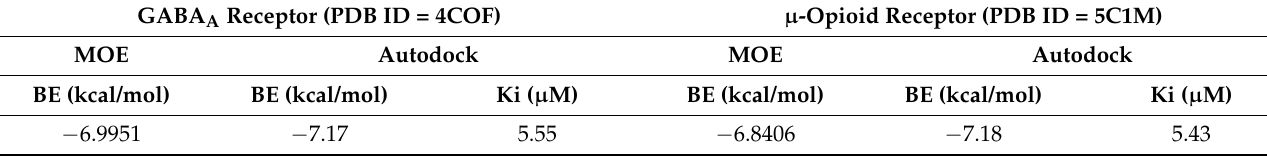
Table 6. Binding energy and inhibition constant of the salicylalazine calculated by Autodock into the binding site of µ -opioid and GABA A